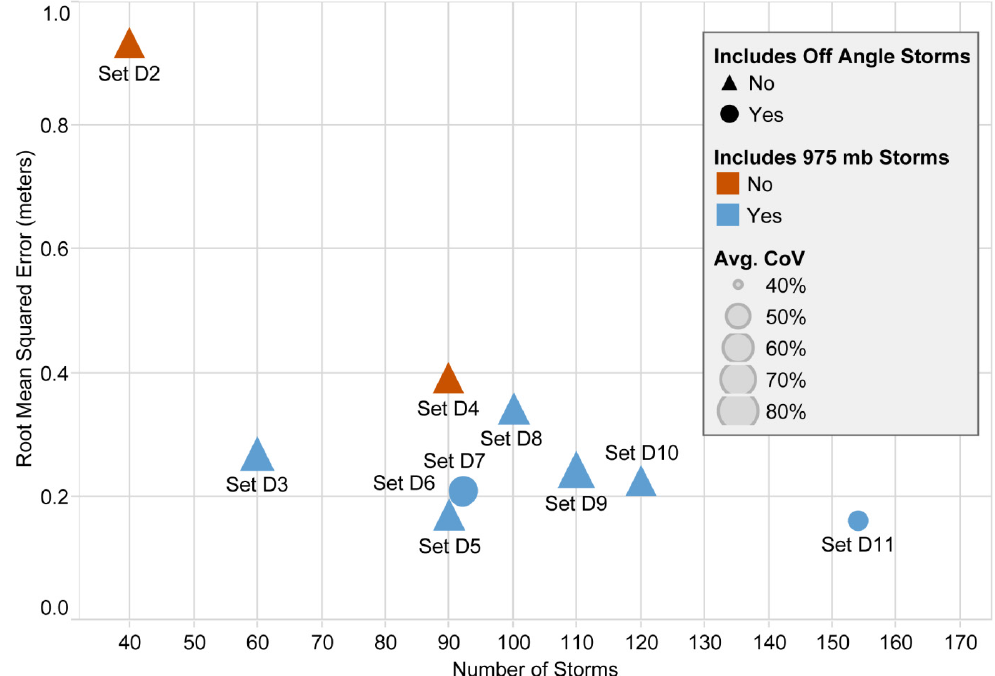
Figure 3. Average coastwide bias and variation by number of storms (detailed analysis), 100-year flood depths.